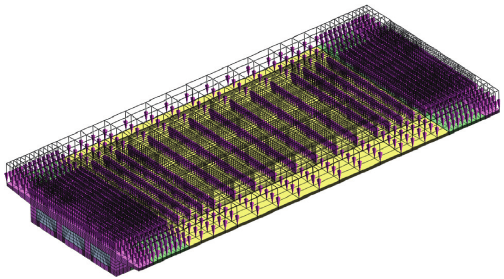
Figure 4: FEM of shear force distribution.